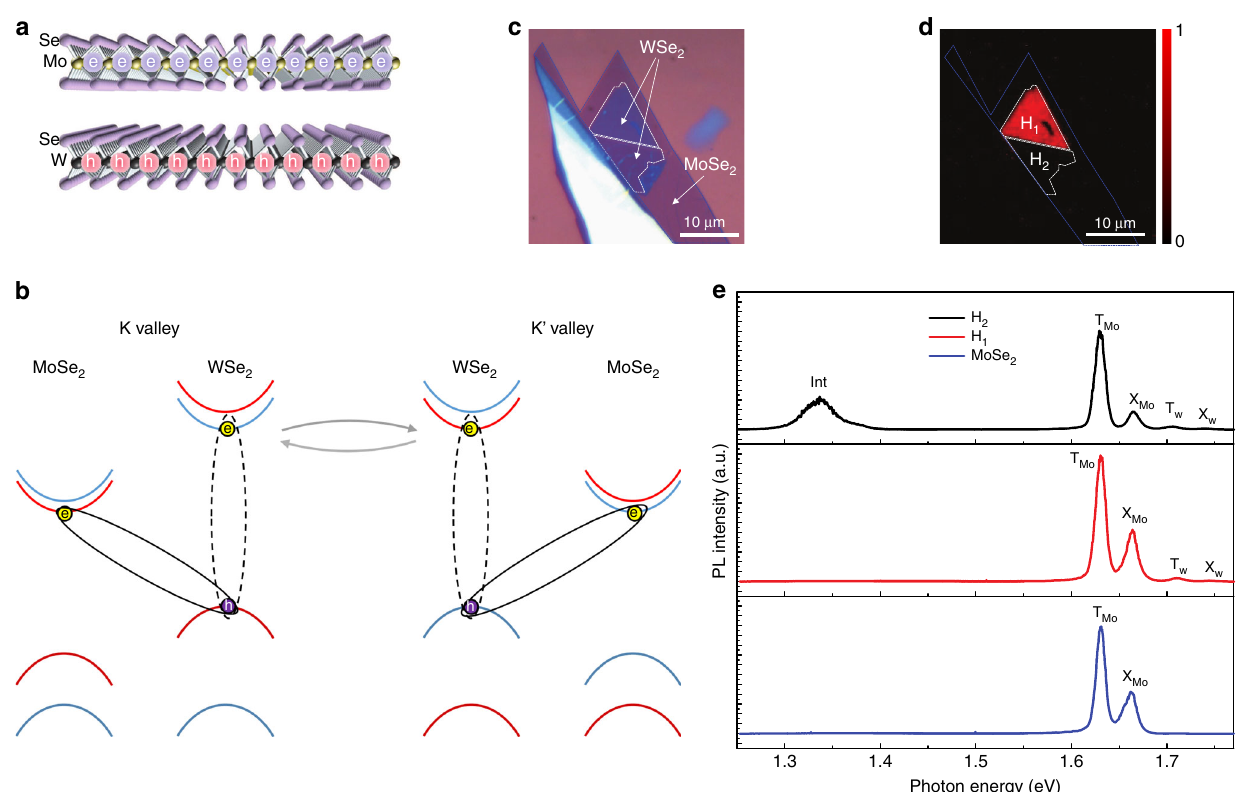
Fig. 1 Sample characterization. a MoSe 2 and WSe 2 form a 2D heterostructures, where electrons are con fi ned in one layer and holes are con fi ned in the other layer. b Schematic of the interlayer exciton and dark exciton. The interlayer excitons are illustrated as solid black ellipses. The dark excitons are represented by the dashed ellipses. Red (blue) curves denote spin-up (spin-down) in the conduction and valence bands while the gray arrowed curves denote the dark exciton valley scattering. c Optical microscope image of the MoSe 2 /WSe 2 heterostructure. Blue dashed line shows the area of MoSe 2 . White dashed lines show the region of heterostructure, which is separated into two areas labeled as H 1 and H 2 in d . d Fluorescence image taken with a color camera under white light excitation. It shows a bright (H 1 ) and dark (H 2 ) state in the two different place of heterostructure. e Photoluminescence in the monolayer MoSe 2 , heterostructure H 1 region, and heterostructure H 2 region under a 633 nm laser excitation. Peaks on MoSe 2 are attributed to exciton (X Mo ) and trion (T Mo ) of MoSe 2 . In H 1 area, another two weak peaks appear and are labeled as exciton (X W ) and trion (T W ) from WSe 2 . In H 2 area, another peak around 1.34 eV emerges, which is attributed to interlayer exciton and labeled as